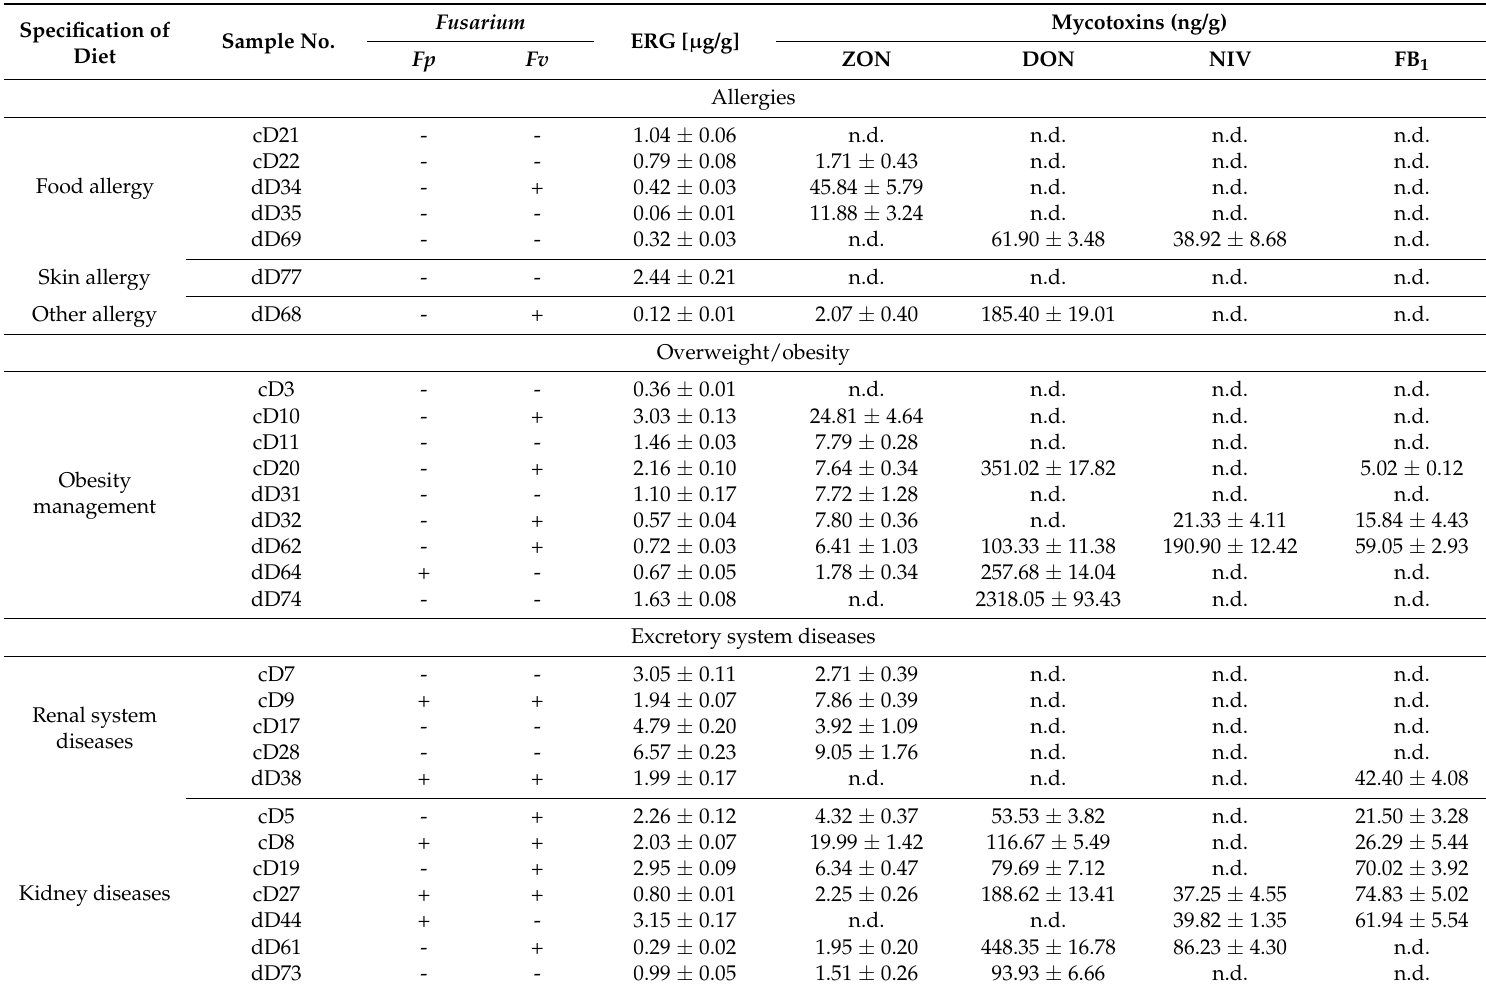
Table 2. Contents of Fusarium fungi, ergosterol ( µ g/g) and mycotoxins (ng/g) in samples of veterinary diets for dogs and